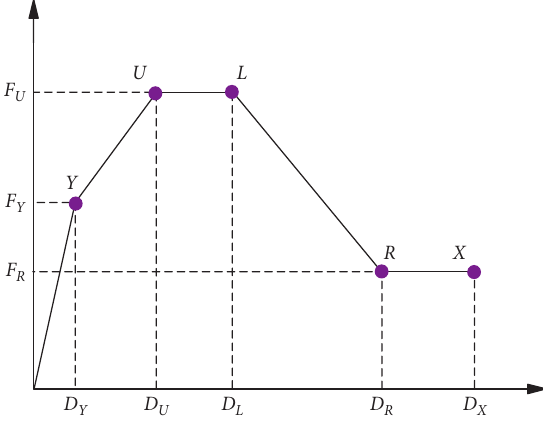
Figure 6: Relationship of F-D in Perform-3D.